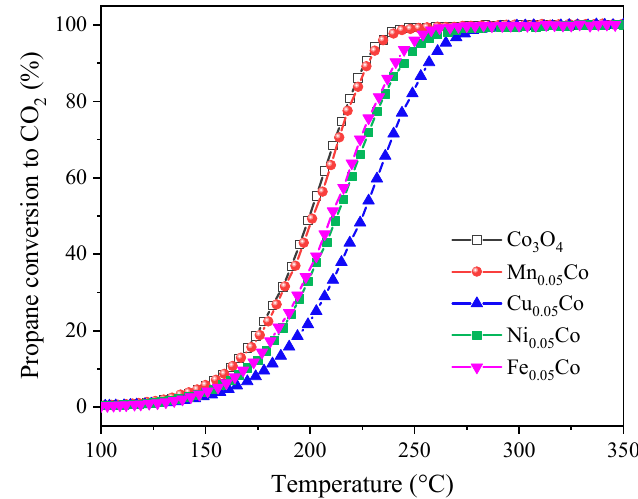
Figure 8. Variation of the propane conversion with the reaction temperature during the cooling run over the Co 3 O 4 and M 0.05 Co catalysts.